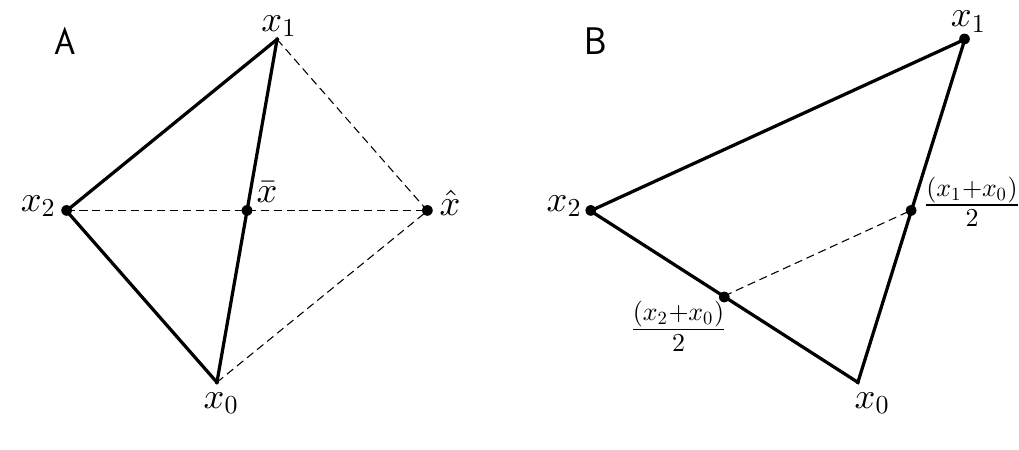
Figure A1. Illustration of the original simplex method. The points x 0 , x 1 , and x 2 form the initial simplex. ( A ) The point ¯ x is the midpoint of the line joining x 0 and x 1 , and ˆ x is the reflection of x 2 through this line. If f ( ˆ x ) < f ( x 1 ) , x 2 is replaced by ˆ x , shifting the location of the simplex. ( B ) If f ( ˆ x ) ≥ f ( x 1 ) , x 2 is replaced with ( 1/2 )( x 2 + x 0 ) and x 1 is replaced with ( 1/2 )( x 1 + x 0 ) , reducing the volume of the